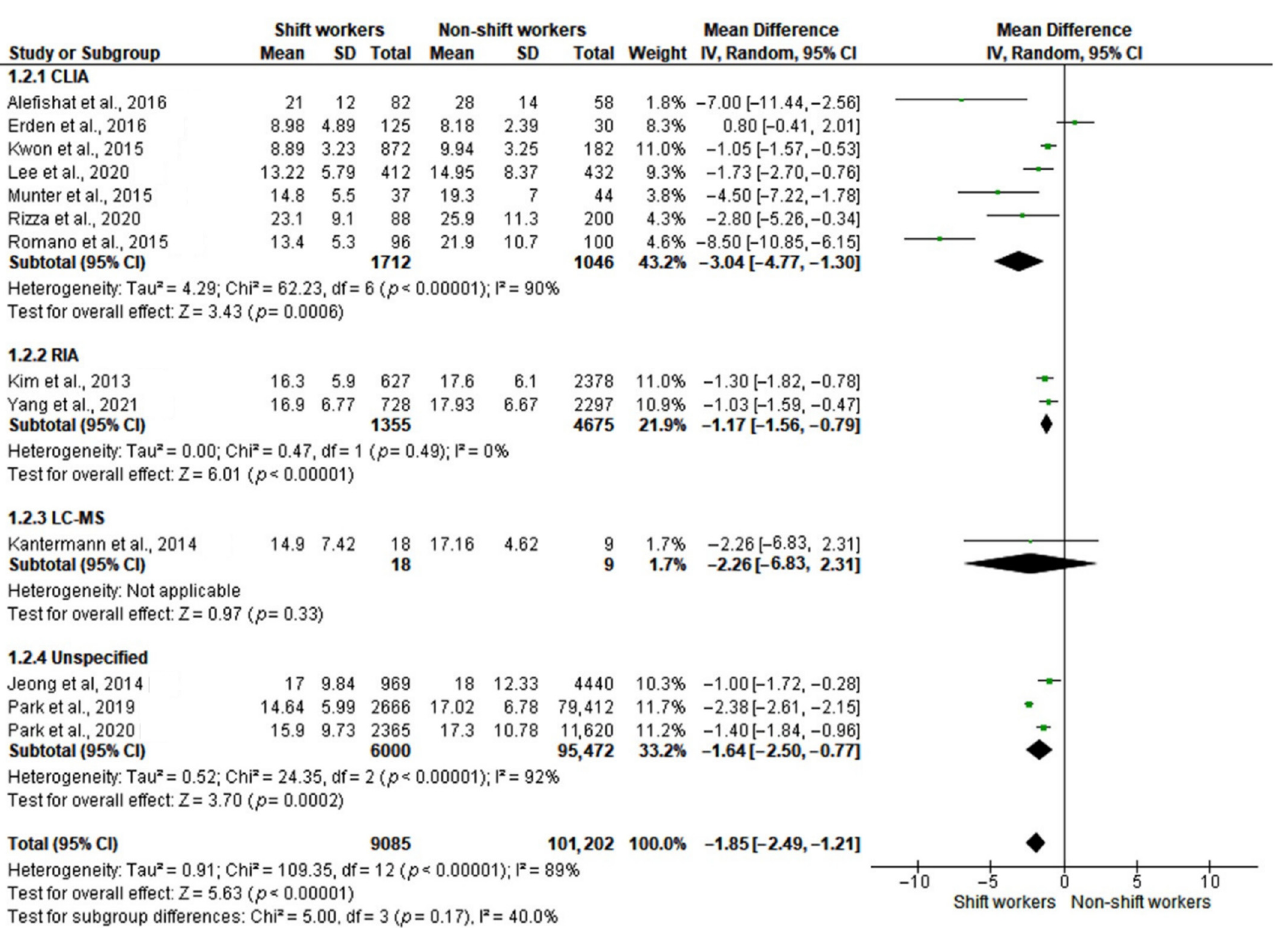
Figure 4. Forest plots showing mean differences in serum 25-hydroxyvitamin D (25-OH-D) levels (ng/mL) in shift workers and non-shift workers (subgroup 1: methods of vitamin D measurement) [12,24–35].